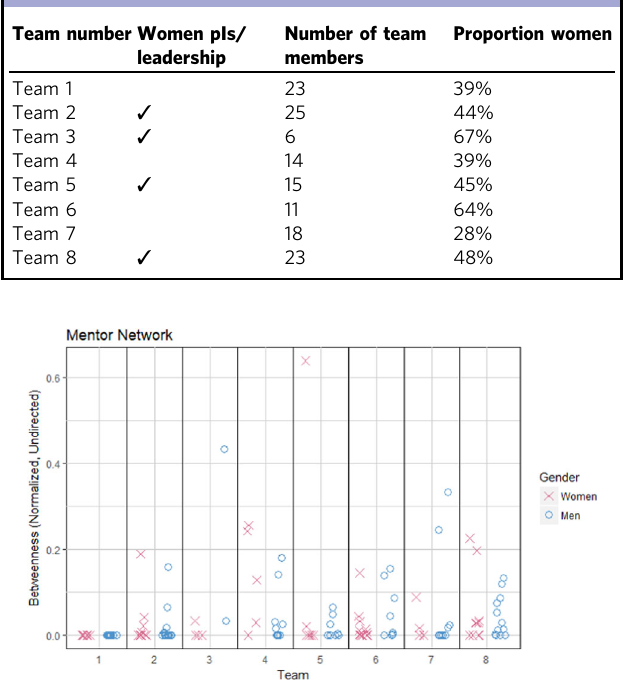
Fig. 1 Women play signi fi cant role in mentor network on teams.